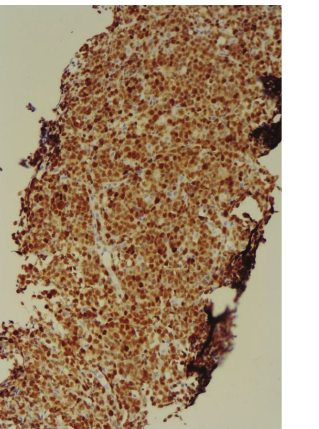
Figure 10: Adrenal biopsy immunohistochemical staining showing positive MUM1